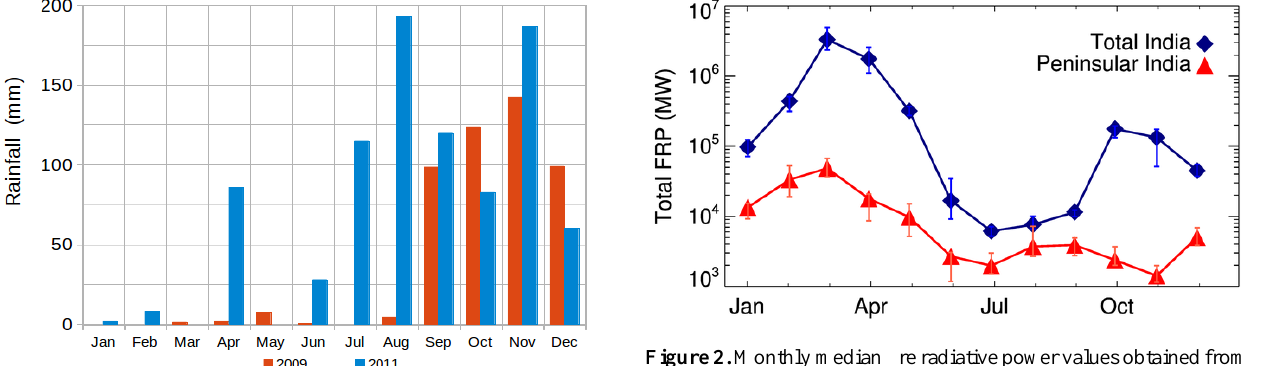
Figure 2. Monthly median fire radiative power values obtained from MODIS satellite for whole India and peninsular India (south of 18 ◦ N